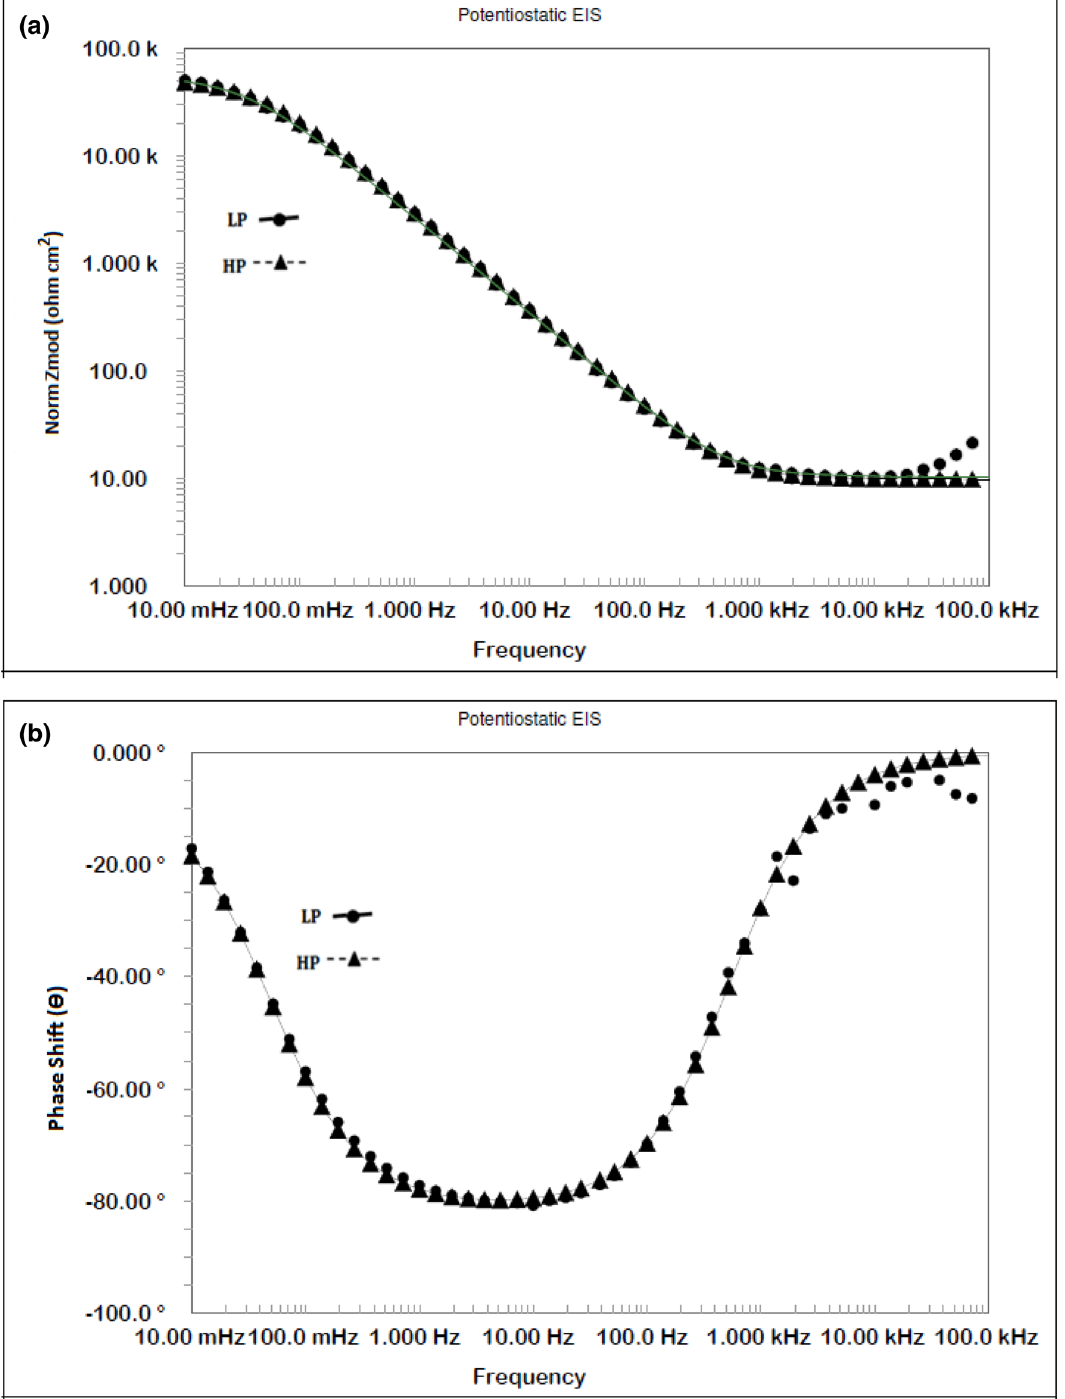
Figure 12. ( a ) Electrochemical frequency–impedance Bode plots for HP and LP steel bars after 24 h of their exposure in chloride added SPSL. ( b ) Electrochemical frequency–phase shift Bode plots for HP and LP steel bars after 24 h of their exposure in chloride added